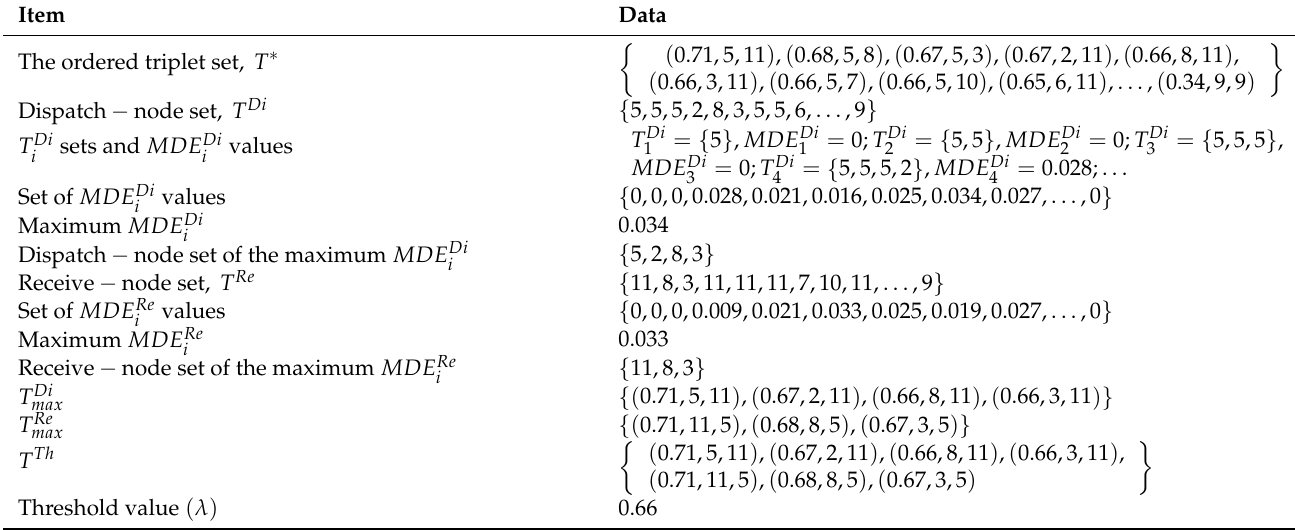
Table 3. Results of MMDE